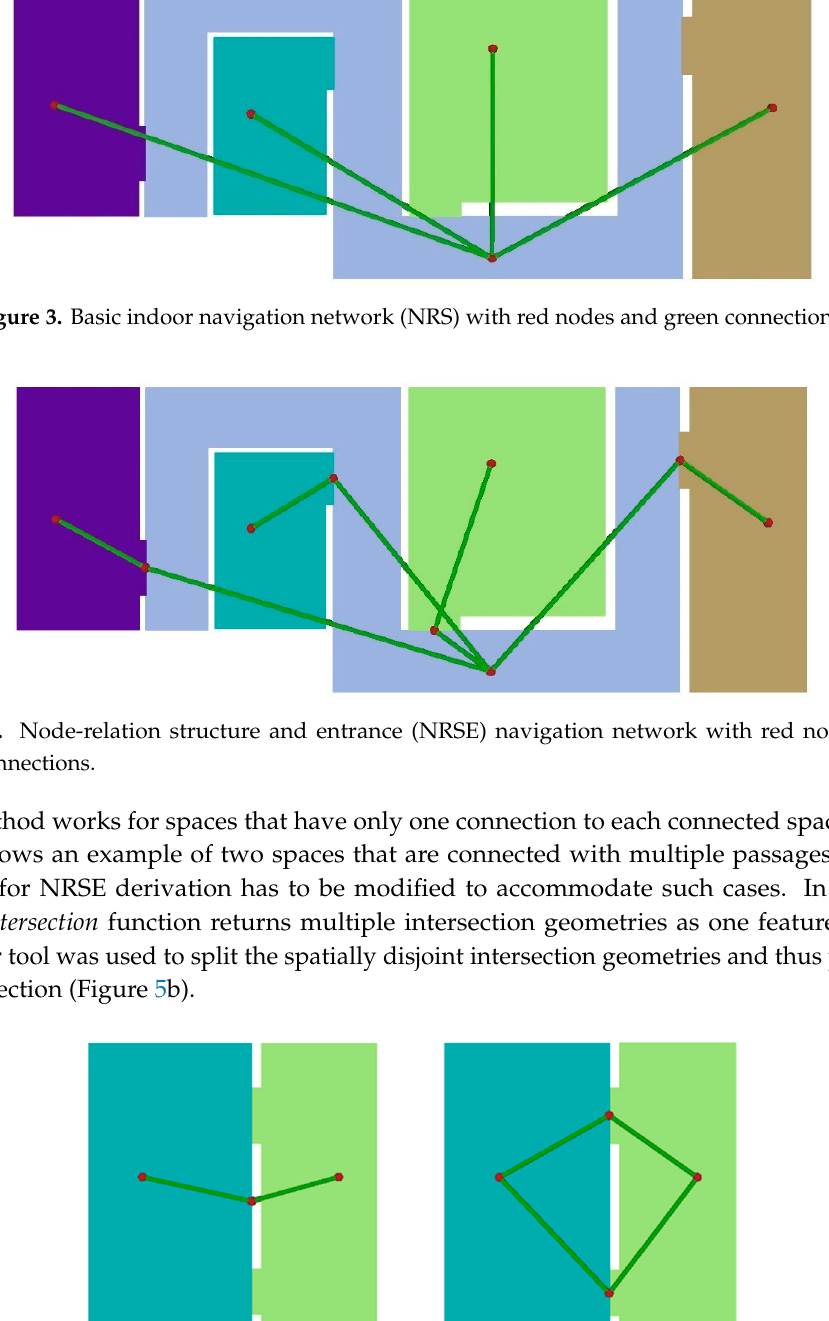
ISPRS Int. J. Geo-Inf. 2020 , 9 , 417